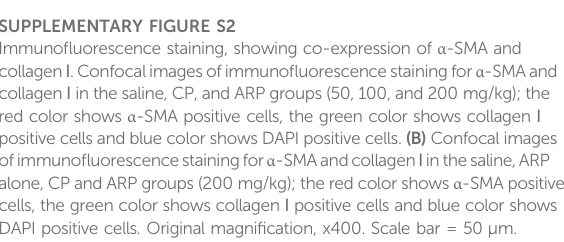
Melting curves of qRT-PCR. Melting curves for GAPDH, (B) Acta-2, (C) Collagen Ⅰ , (D) FN1 and (E) PPP2R2A. SUPPLEMENTARY FIGURE S2 Immuno fl uorescence staining, showing co-expression of α -SMA and collagen Ⅰ .Confocalimagesofimmuno fl uorescencestainingfor α -SMAand collagen Ⅰ in the saline, CP, and ARP groups (50, 100, and 200 mg/kg); the red color shows α -SMA positive cells, the green color shows collagen Ⅰ positive cells and blue color shows DAPI positive cells. (B) Confocal images ofimmuno fl uorescencestainingfor α -SMAandcollagen Ⅰ inthesaline,ARP alone, CP andARP groups (200 mg/kg); the red color shows α -SMA positive cells, the green color shows collagen Ⅰ positive cells and blue color shows DAPI positive cells. Original magni fi cation, x400. Scale bar = 50 μ